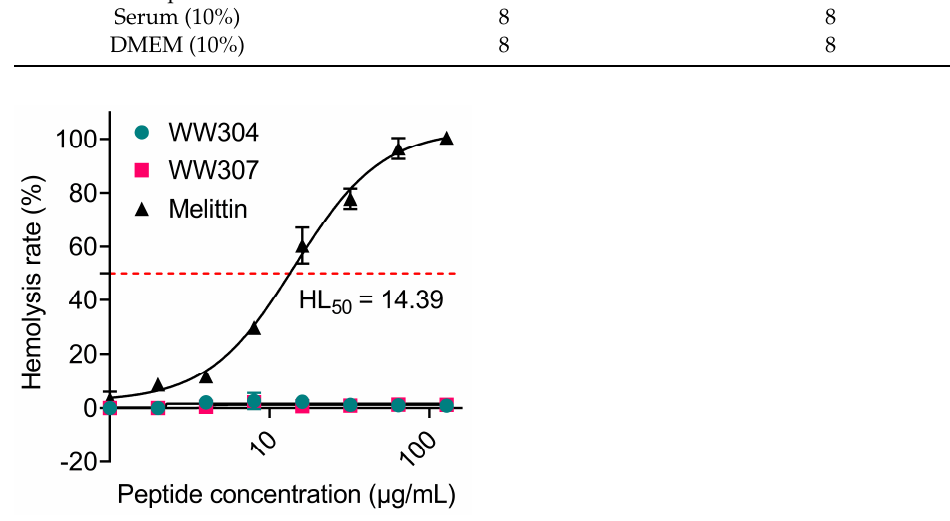
Figure 6. Hemolytic activity of peptides against mammalian red blood cells (RBCs). HL 50 is the peptide concentration that causes 50% hemolysis. Sterilized PBS and ddH 2 O were used as a nega ‐ tive control and positive control, respectively.